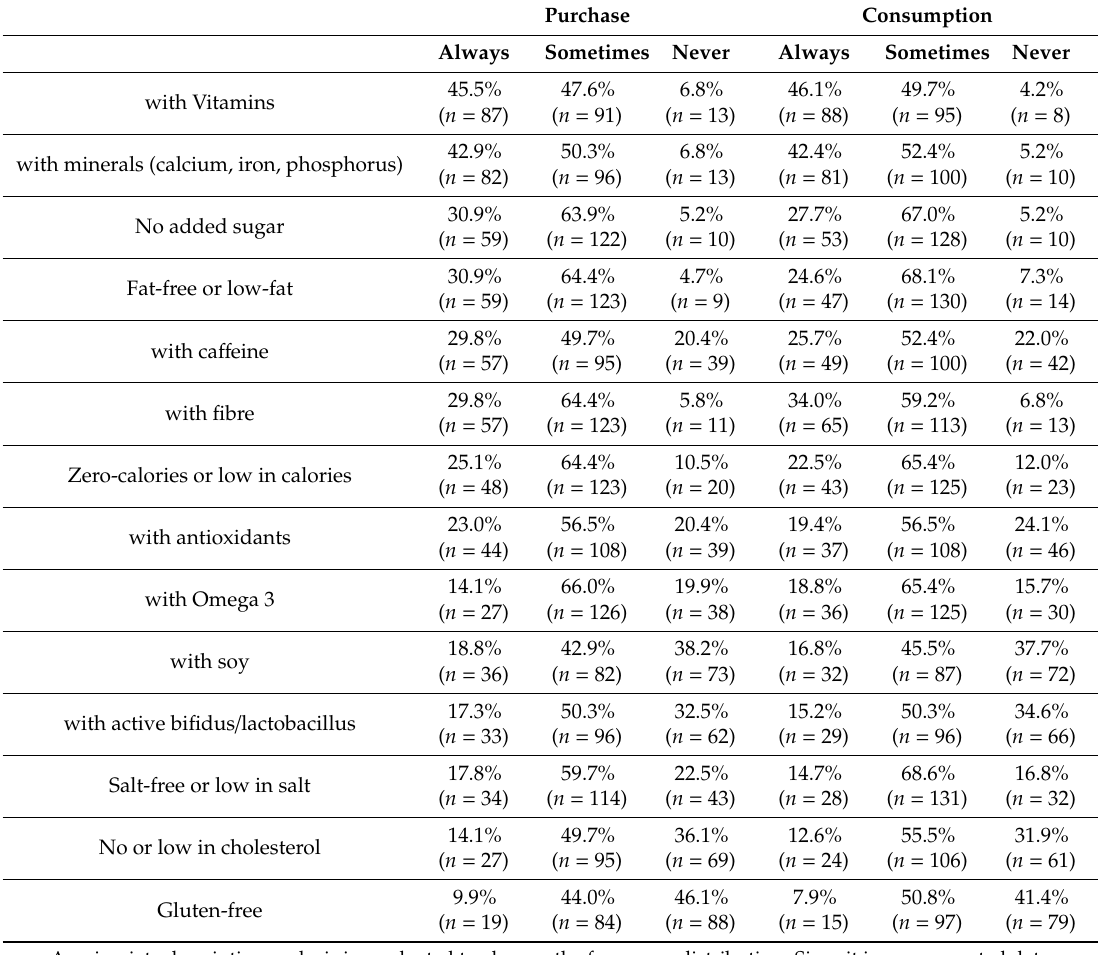
Table 1. Purchase and consumption of functional products according to their